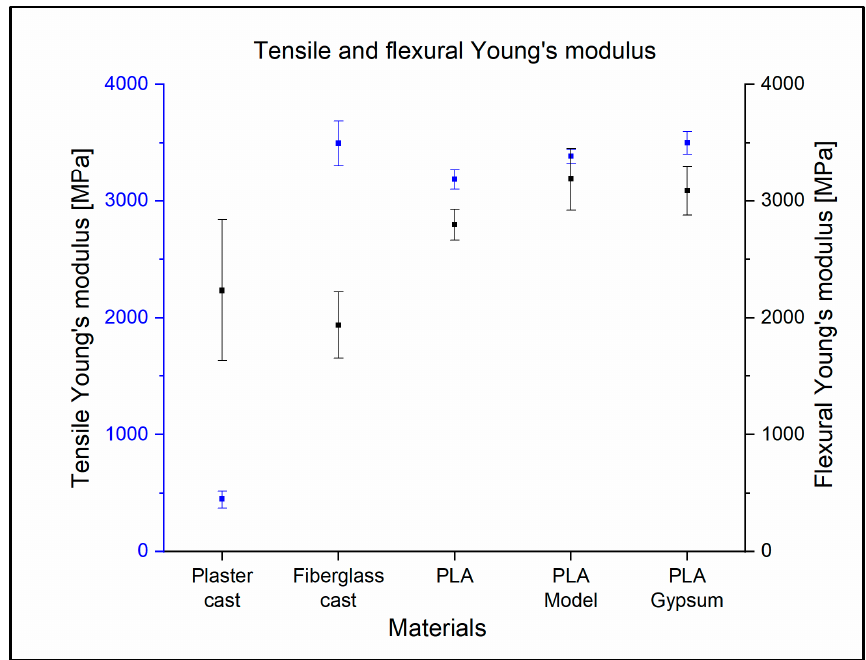
Figure 6. Tensile and flexural Young’s modulus of the casting materials. Black squares indicate the mean of the flexural Young’s modulus; black lines refer to standard deviations in case of flexural test. The blue squares and lines indicate the mean of tensile Young’s modulus and standard deviation in tensile tests.